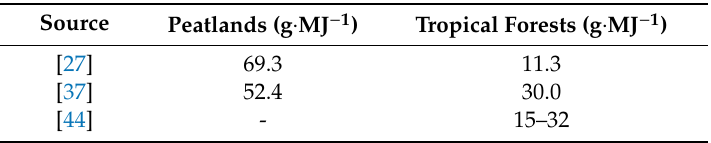
Figure 3. Comparison of total particulate matter (TPM) in the plume subset and matching fire radiative energy (FRE) released from the causal fire, shown for the thirteen matchup fires of Figure 2, with each numbered as shown therein. The ordinary least squares (OLS) linear best fit through the origin is used to generate a TPM smoke emissions coe ffi cient ( C e ; 16.8 g · MJ − 1 ) appropriate for this type of highly radiant SE Asian peatland fire, with the grey shaded area indicating the 95% confidence interval [14.3 g · MJ − 1 , 20.9 g · MJ − 1 ]. Table 2. Existing peatland and tropical forest fire TPM smoke emissions coe ffi cients ( C e ) linking TPM emissions to FRE release, for comparison to that derived herein (Figure 3).